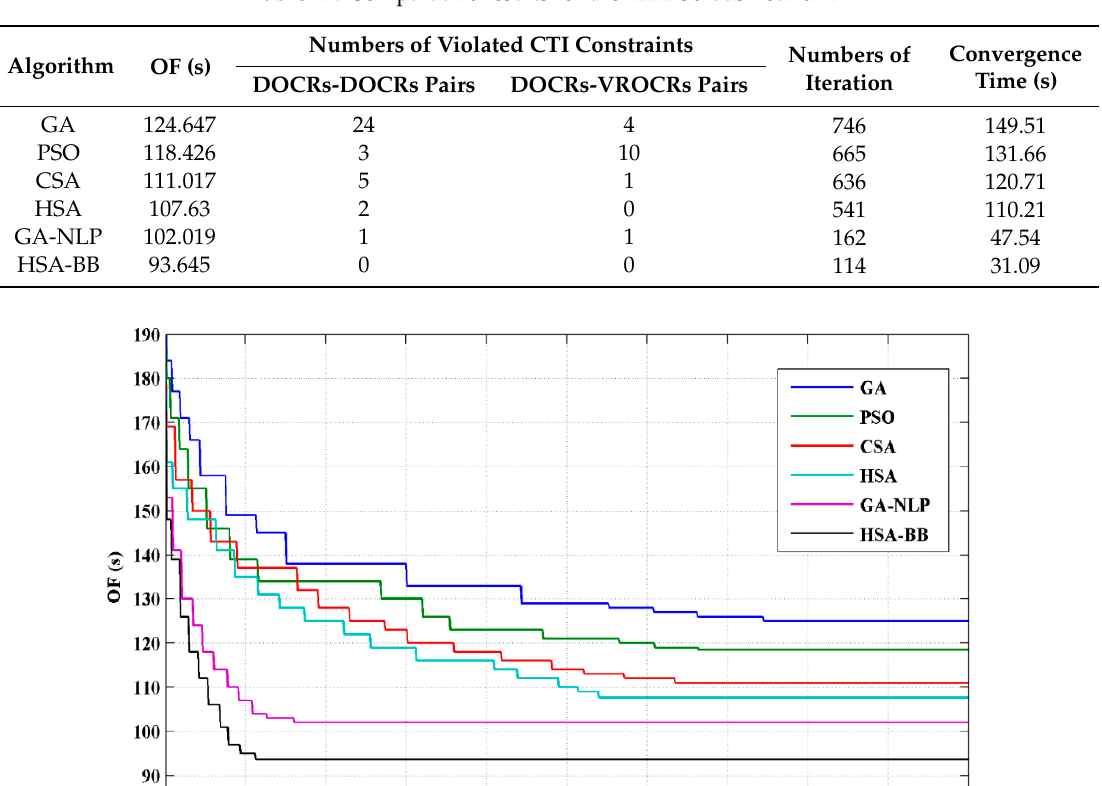
Table 11. Comparative results for the IEEE 30-bus network.